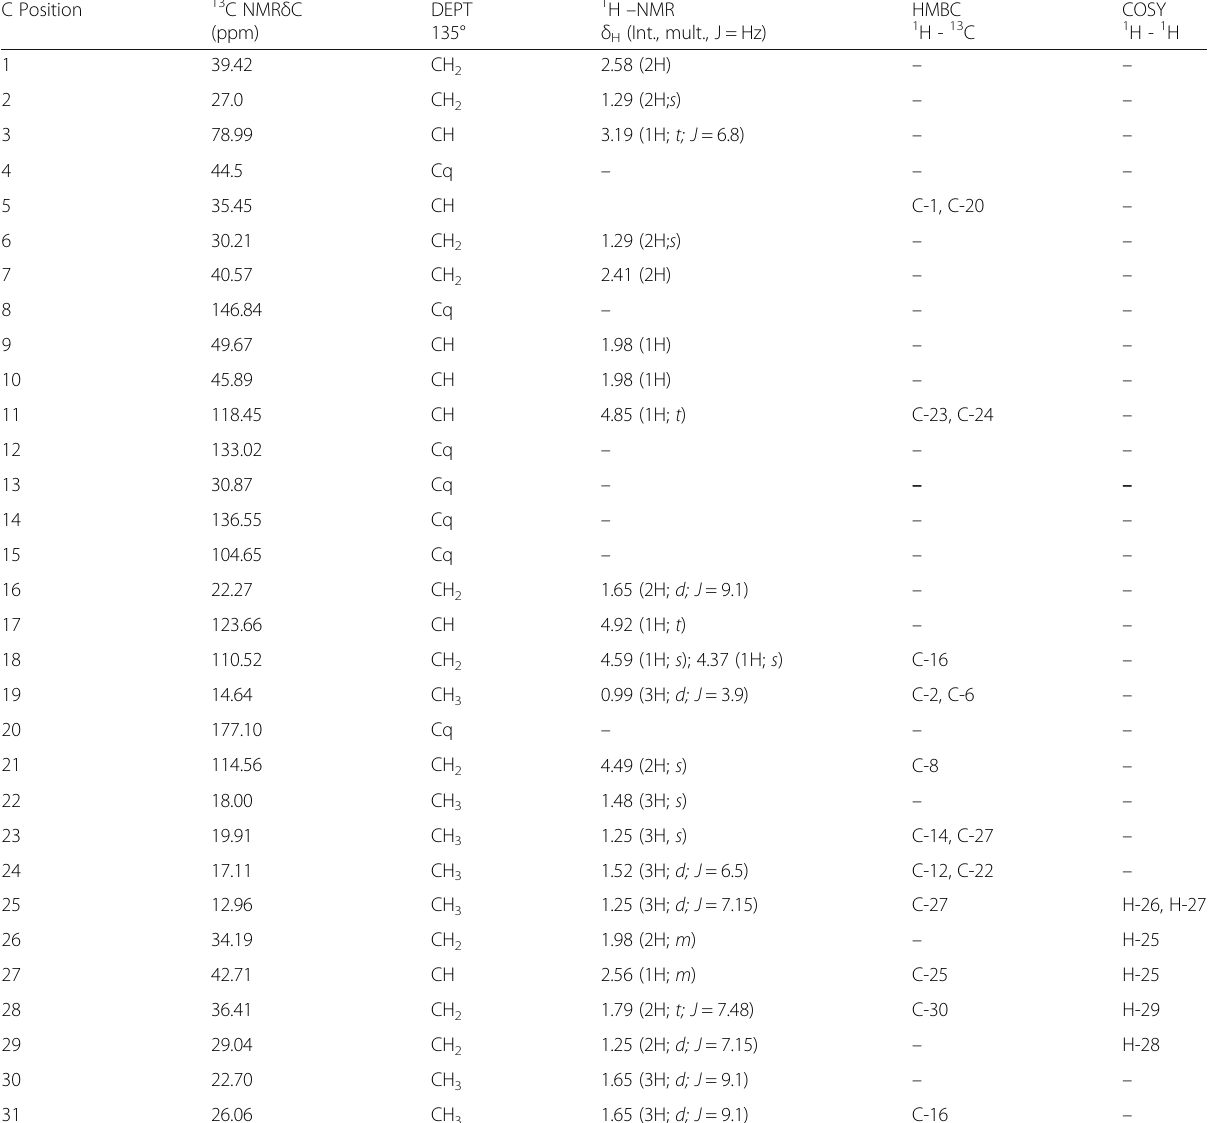
Table 1 NMR data of compound 1 (500 MHz for 1 H NMR and 125 MHz for 13 C NMR, CD 3 OD) C